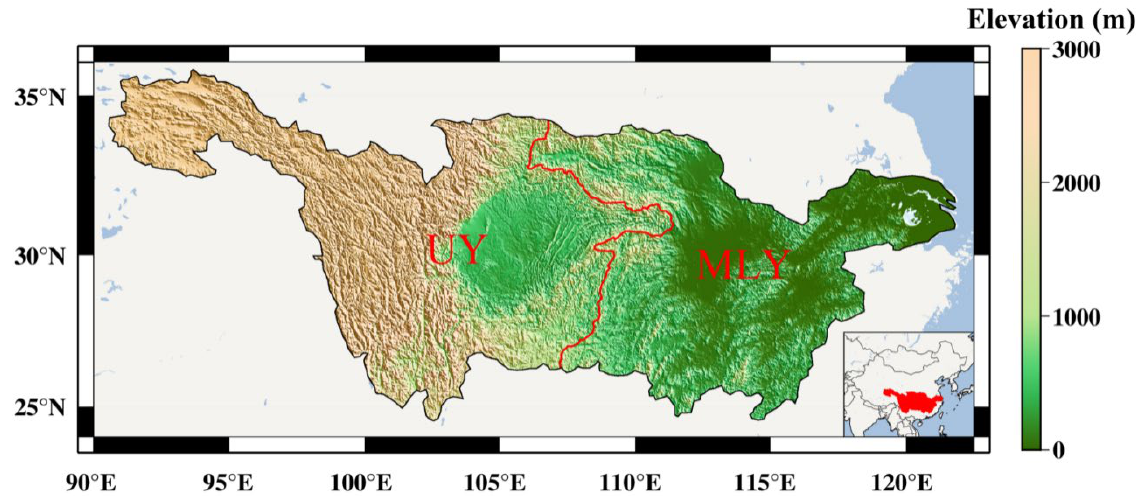
Figure 1. Digital elevation model of YRB (UY: the upper of YRB; MLY: the middle and lower of YRB) .